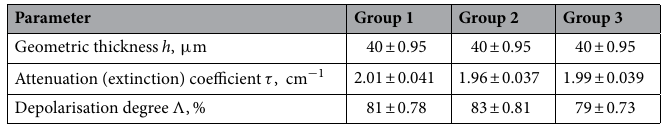
Table 1. Optical and geometric parameters of histological sections of prostate